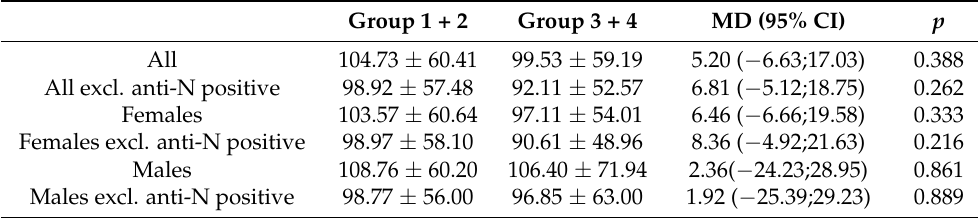
Table 7. Comparison of anti-S antibody levels between groups based on time of the first vaccination.